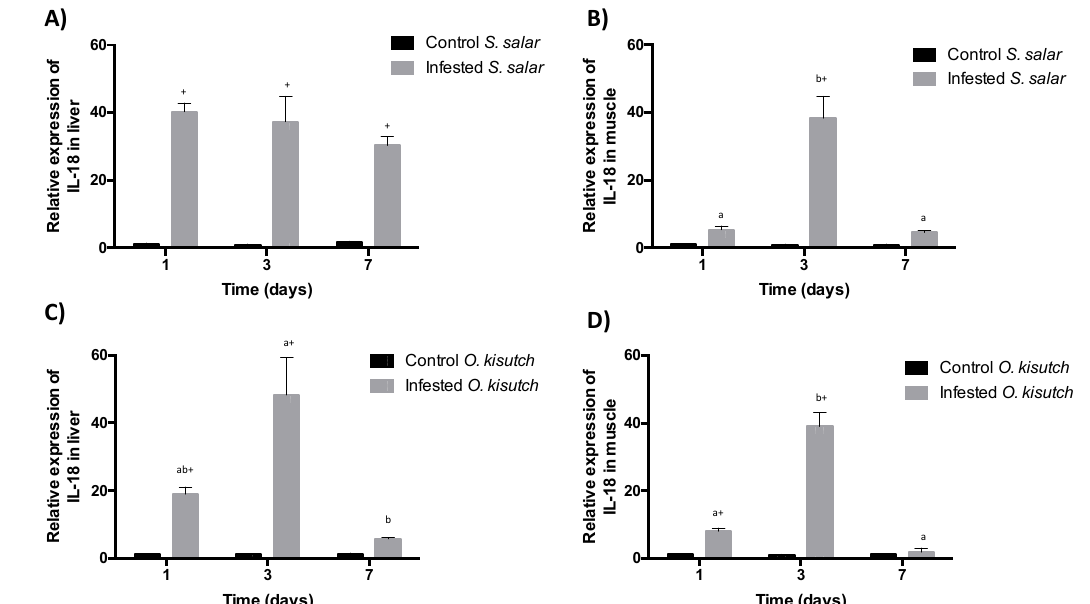
Figure 2. Relative expression of IL-18 transcripts in Salmo salar and O. kitsuch muscle infested with C. rogercresseyi . Relative mRNA expression of IL-18 in muscle at 1, 3, and 7 dpi ( B , D ) and relative mRNA expression of IL-18 in liver at 1, 3, and 7 dpi ( A , C ). The 18s gene was used as a reference gene to calibrate the cDNA template for all samples. Bars represent the mean values (± S.E.) of 20 samples. Letters (a,b,c) represent statistical differences within the same group over time. The + symbol represents statistical differences at the same time-point between groups (i.e., infested vs. control). Statistical differences were established by two-way ANOVA ( P < 0.05).